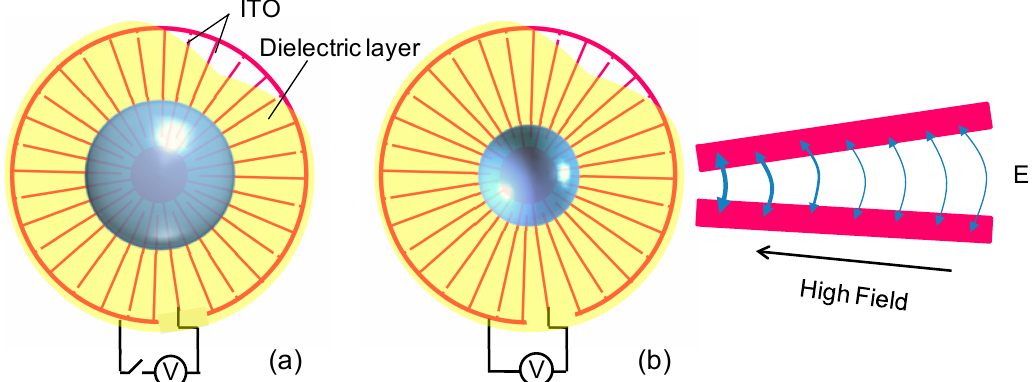
Figure 1. A liquid droplet placed on a radial-patterned electrode in the ( a ) relaxed state and ( b ) contracted state. The right chart of ( b ) shows the fringing field between adjacent ITO stripes.